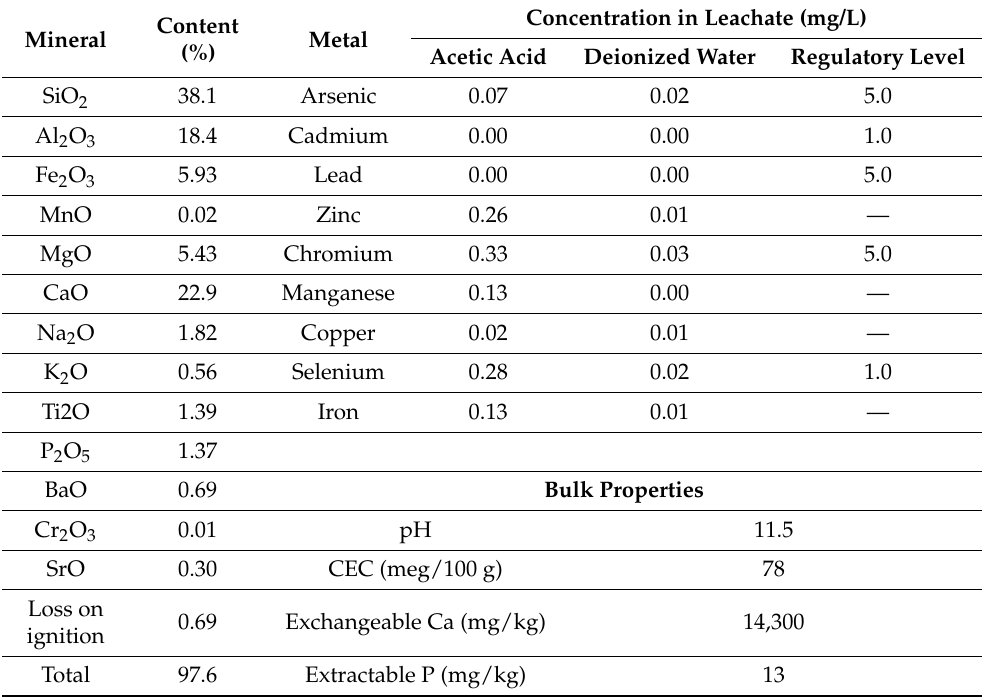
Table 1. Fly ash mineral composition, metal leaching, and bulk properties